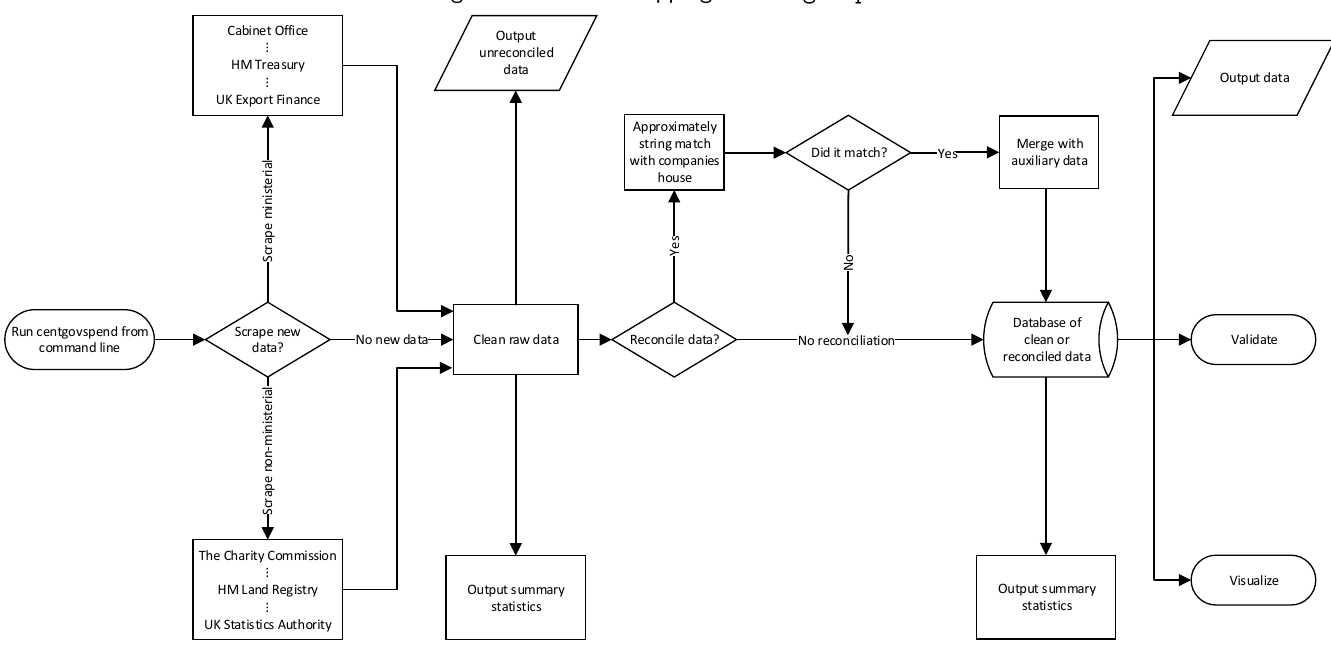
Figure 2: Process Mapping of centgovspend